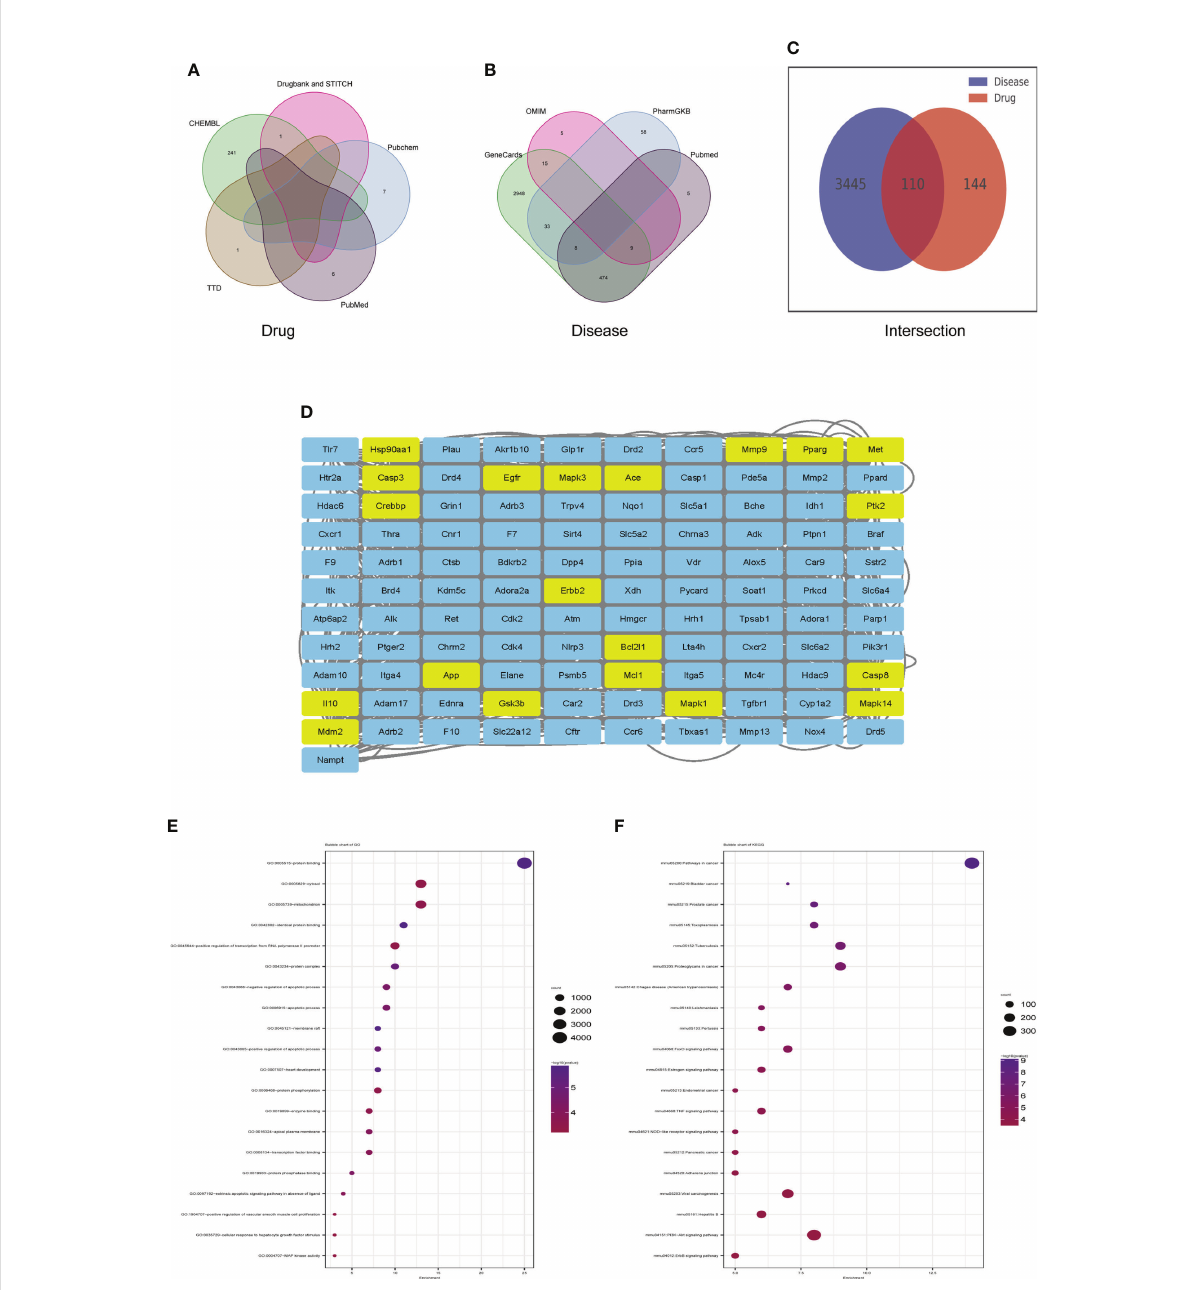
FIGURE 6 Identi fi cation of candidate targets of Dapagli fl ozin in the treatment of DN by network pharmacology. (A) The Veen diagram showing candidate targets of dapagli fl ozin from the drug database. (B) The Veen diagram showing candidate targets of DN from disease databases. (C) Overlap of the differentially expressed genes between candidate targets of dapagli fl ozin and DN. (D) PPI network of the 110 overlapping genes between candidate targets of dapagli fl ozin and DN. The top 20 core genes were highlighted in yellow. (E, F) GO (E) and KEGG (F) enrichment analysis of the top 20 core genes. DN, diabetic